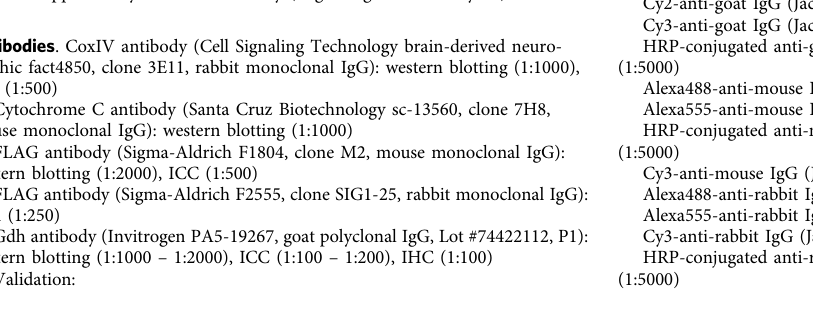
Validation: Western blotting: a strong signal at the expected 212 kDa for mESC and at 130kDa for murine brain, but not for mESC TET TKO cells (Supplementary Fig. 7)